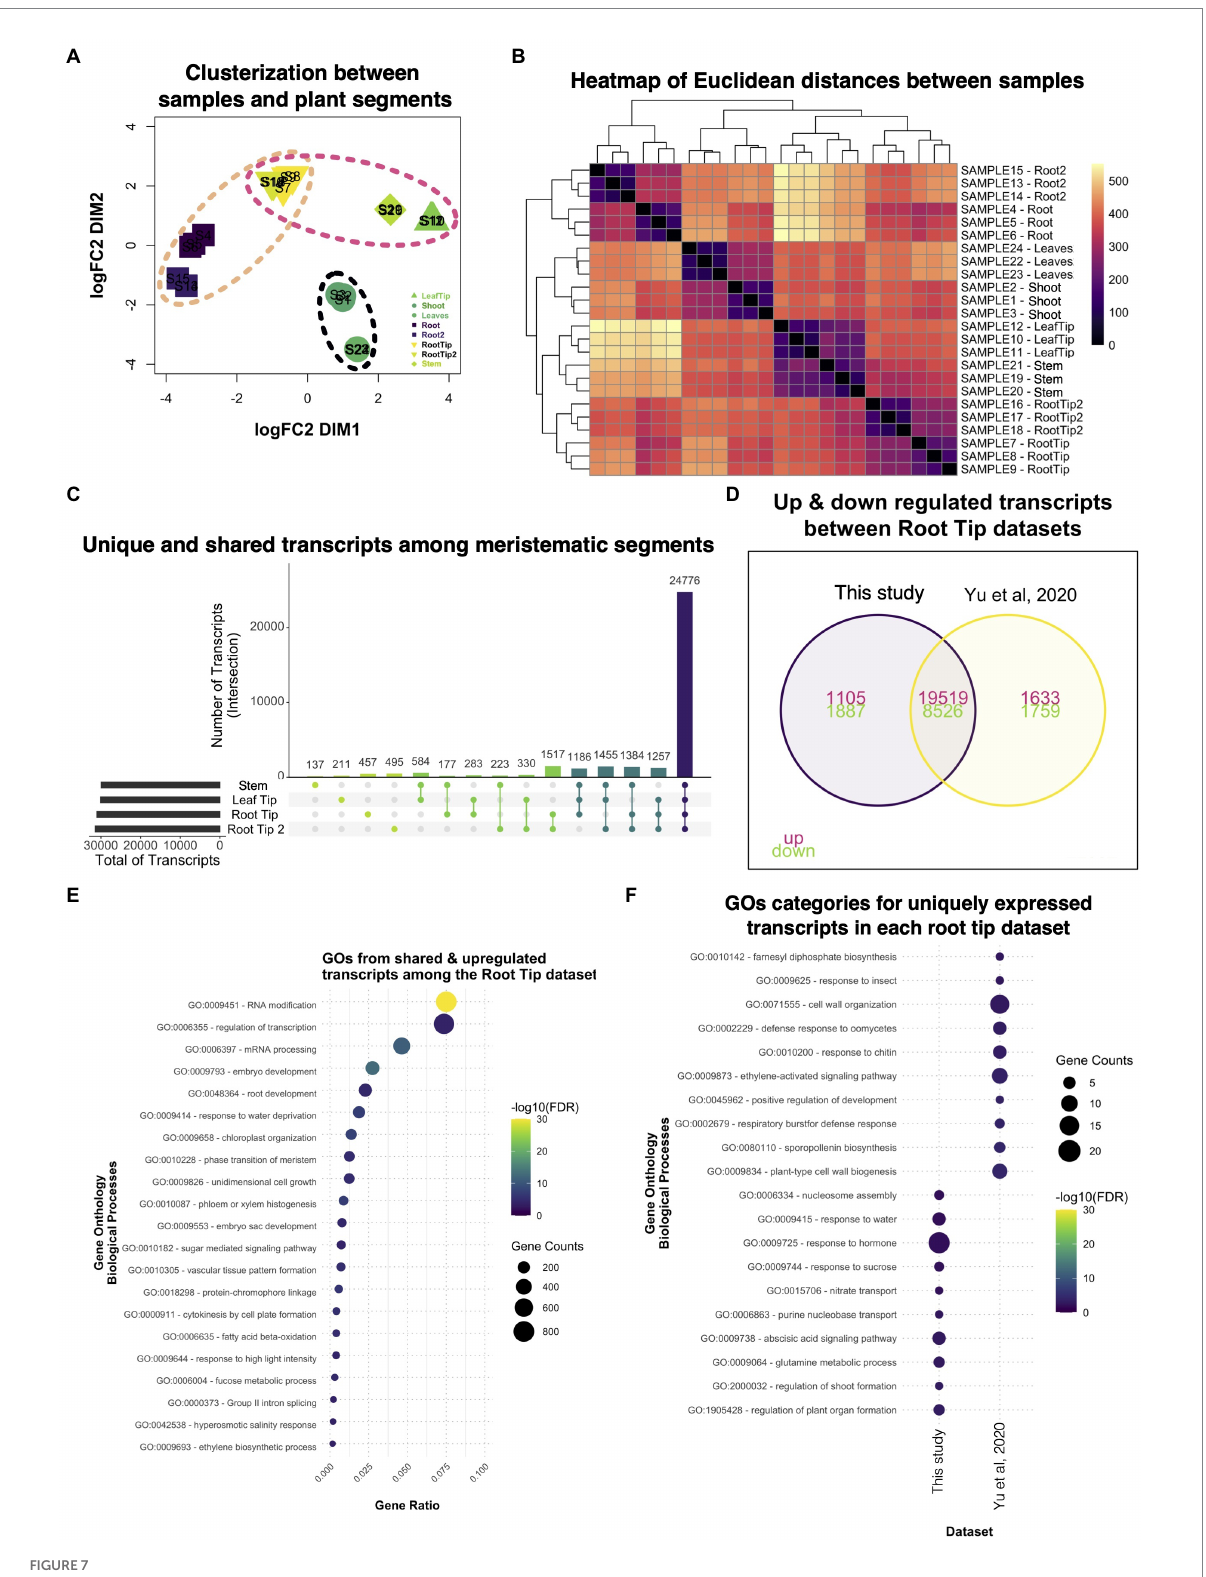
FIGURE 7 Comparative analysis between two different datasets of Ceratopteris sporophytic tissues. (A) Multidimensional scaling analysis to examine how similar and contrasting are the samples and plant parts of both datasets. (B) Heatmap showing the relatedness between samples and plant segments in the two datasets. (C) Plot showing the unique and shared transcripts between meristematic segments. (D) Venn diagram exhibiting how many transcripts are shared or unique among root tip datasets. (E) GO enrichment analysis of the shared transcripts between both root tips samples. (F) GO enrichment analysis of transcripts that are expressed uniquely in each root tip